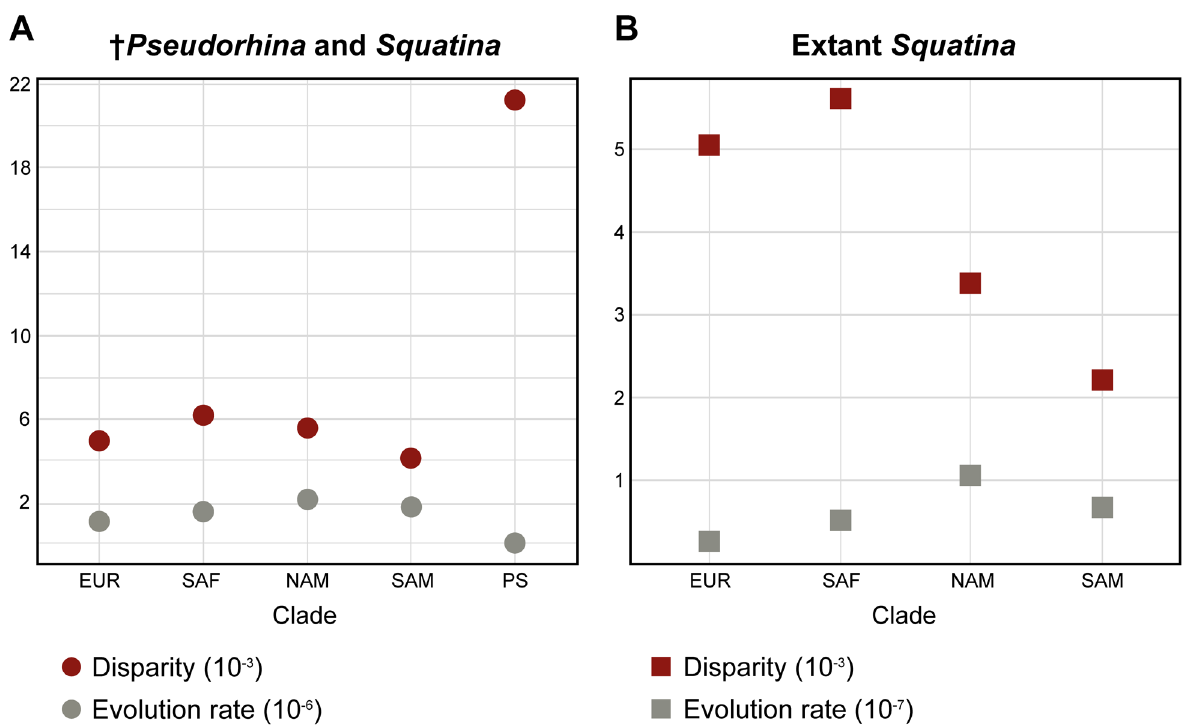
Figure 5. Neurocranial morphological disparity and rate of morphological evolution of the set including the fossil specimens ( A ) and the data set with the living clades of angel sharks ( B